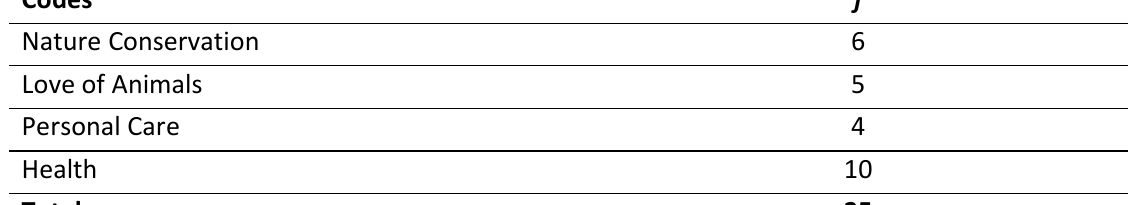
Table 6. Codes and Statistics of Environmental and Health Awareness Theme